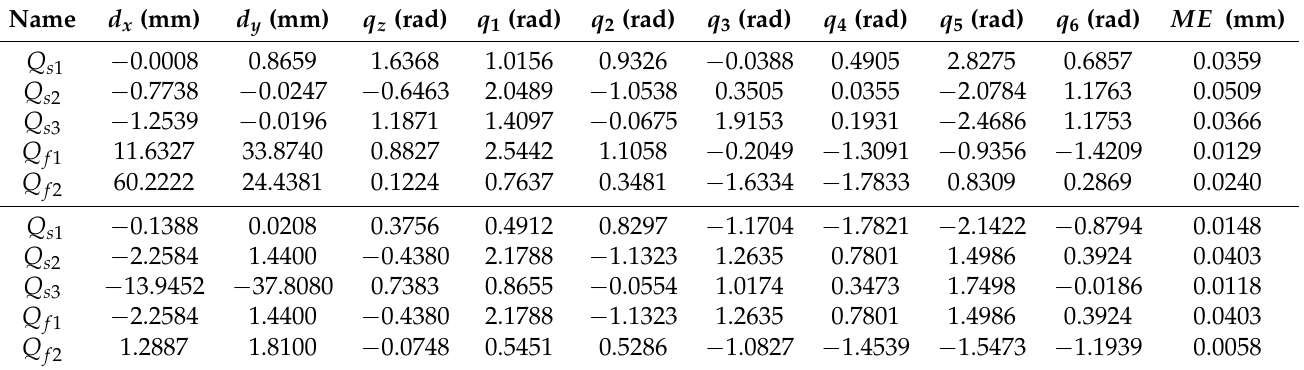
Figure 8. Inverse kinematics analysis of the mobile manipulator robot. ( a ) Solution results for desired position 1; ( b ) Collision detection results based on the typical method for position 1; ( c ) Collision detection results based on the improved method for position 1; ( d ) Solution results for desired position 2; ( e ) Collision detection results based on the typical method for position 2; ( f ) Collision detection results based on the improved method for position 2. Table 5. Solutions of inverse